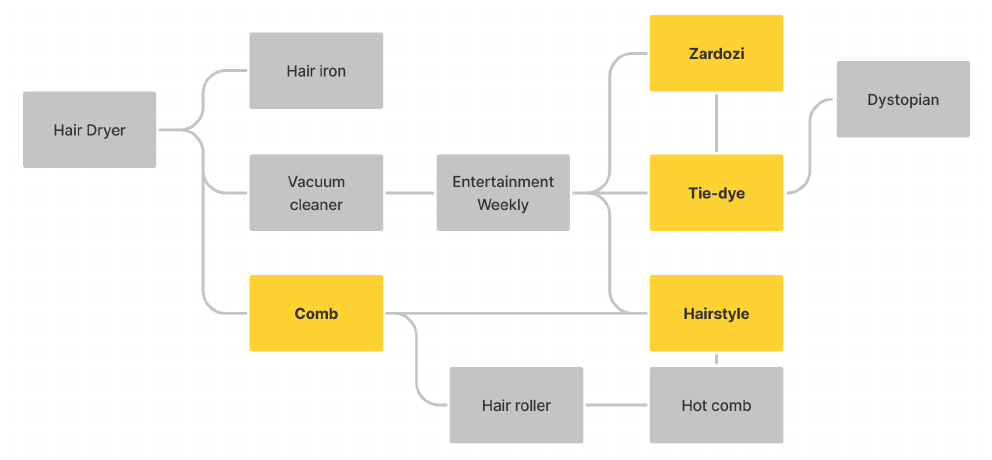
Figure 9. The example of “design inspiration link”.